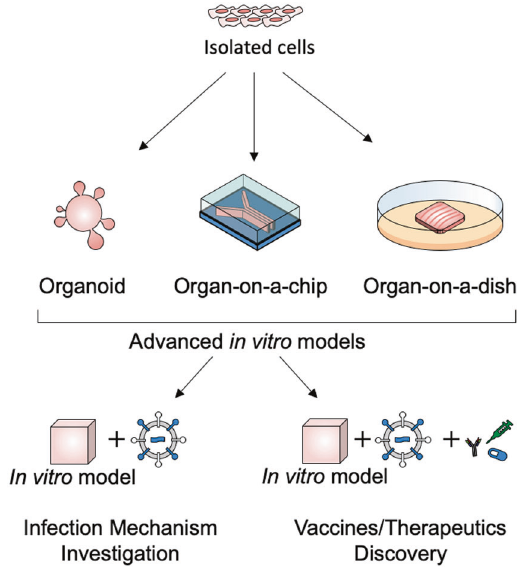
Fig. 3 Advanced in vitro models used in research of infectious disease to identify the infection mechanisms and the effective